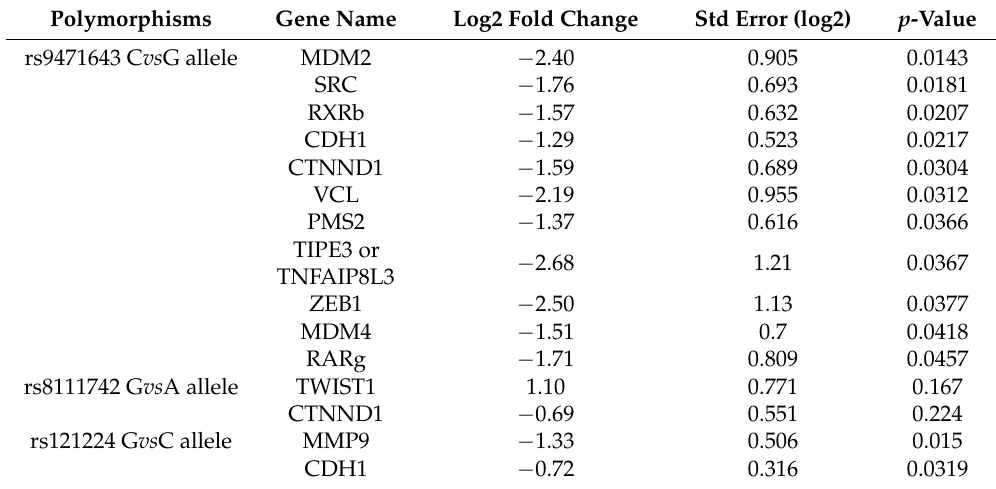
Table 8. Fold change mRNA gene expression associated with PGII and miRNA gene related poly-